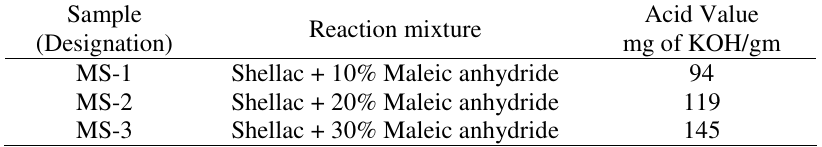
Figure 2. Maleated shellac (MS) Table 1. Acid value of maleated shellac